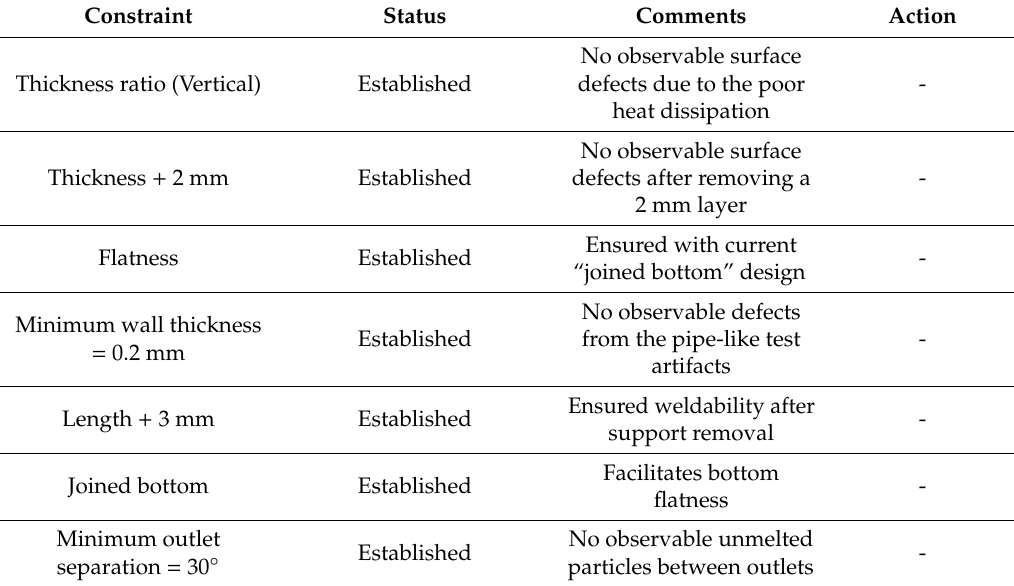
Table 4. AM constraints established after prototyping